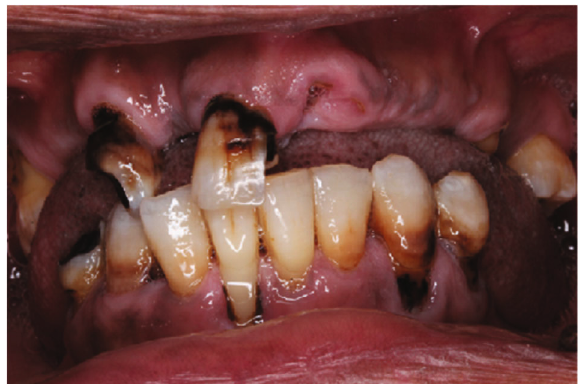
Figure 4: Preoperative upper occlusal view.